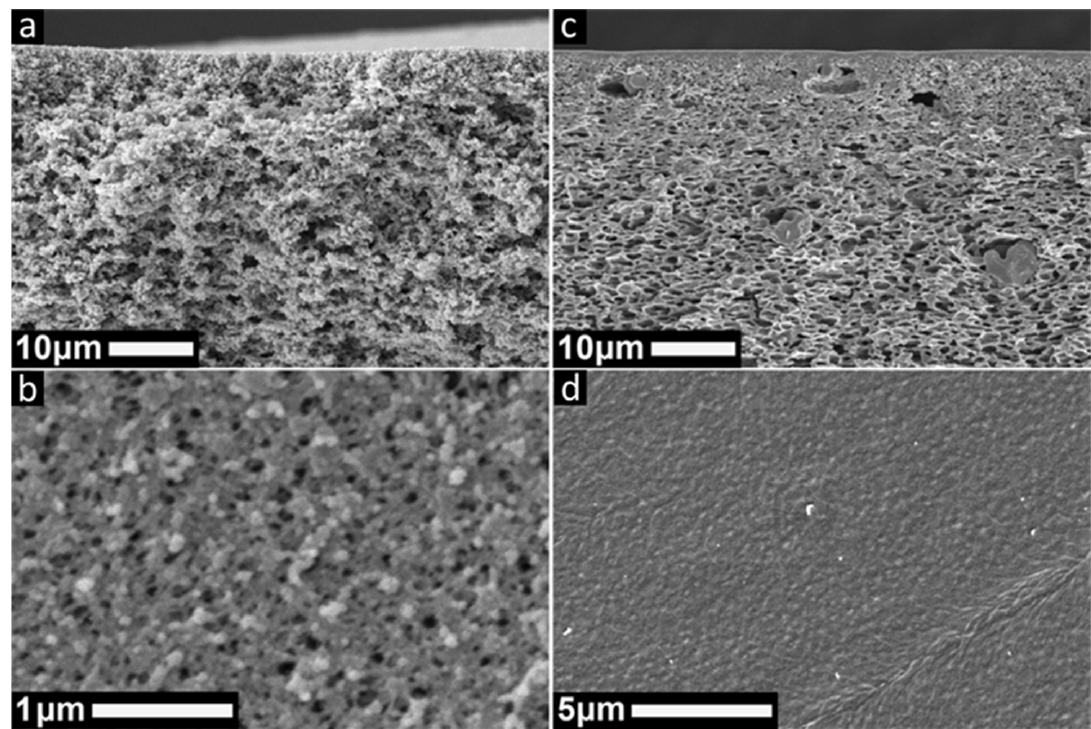
Figure 1. SEM cross-section and top surface images of membranes prepared in a coagulation bath with 0.1 M of HCl ( a , b ) or 2.5 M of H 3 PO 4 ( c , d ) using a 20% w / v PSaMA, 40% v / v acetic acid polymer casting solution.